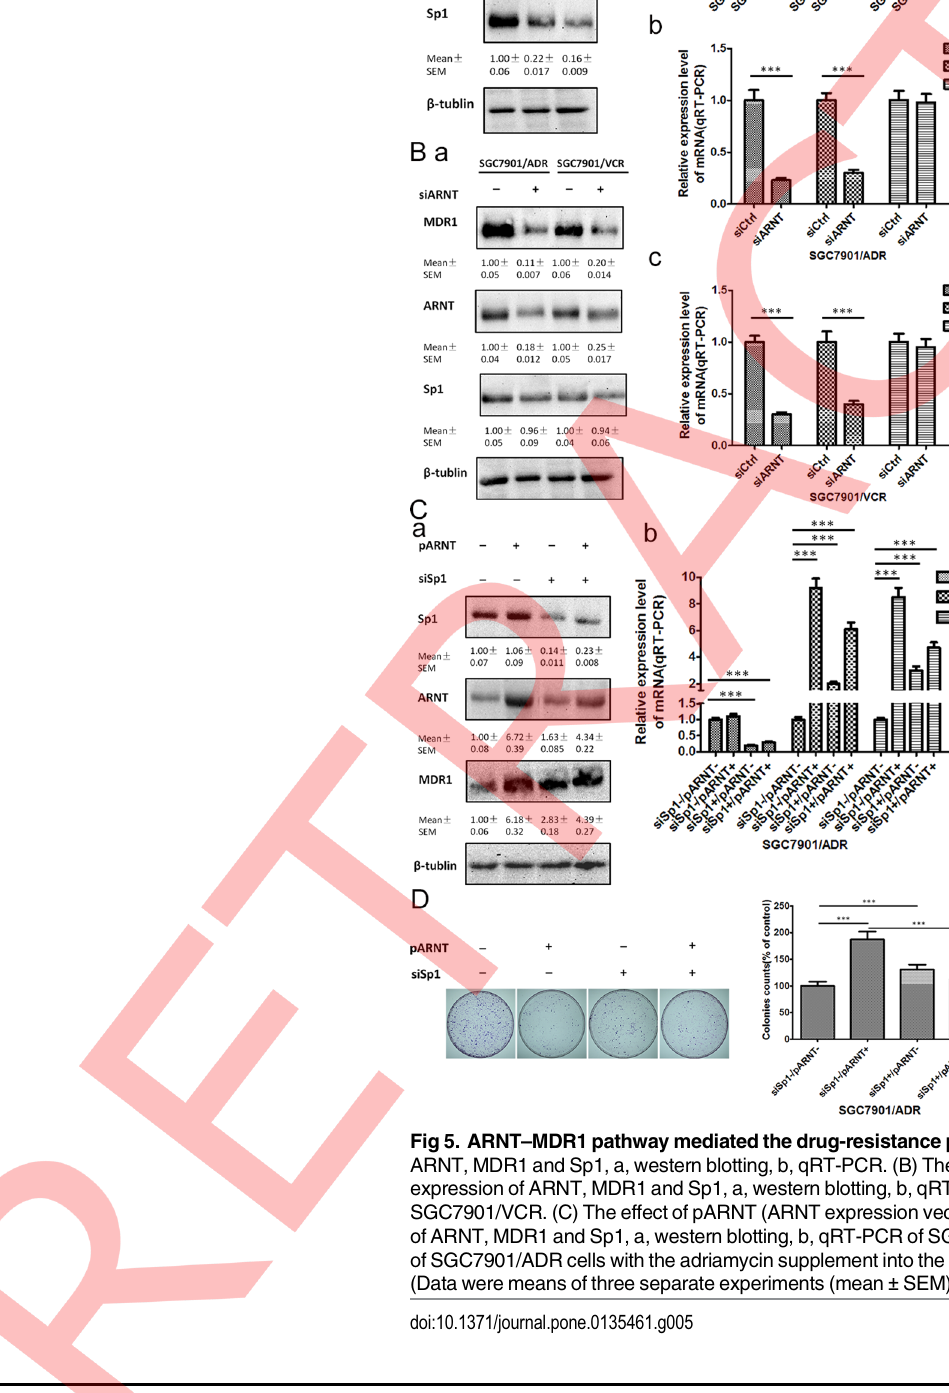
PLOS ONE | DOI:10.1371/journal.pone.0135461 August 20,